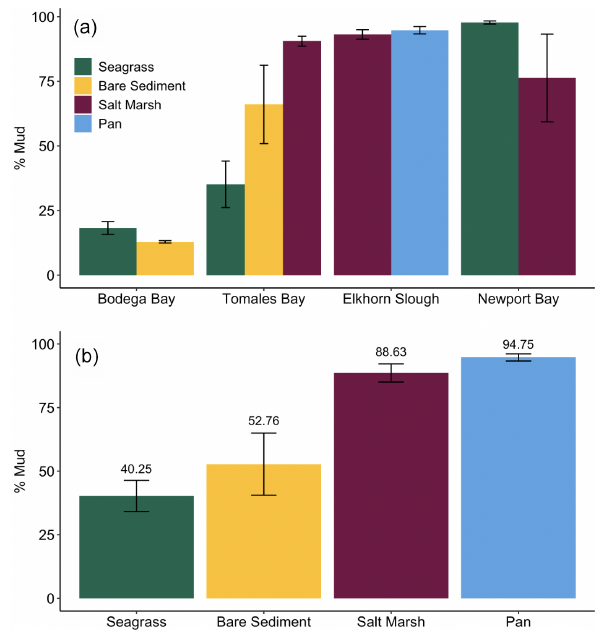
Figure 5. Average ( ± SE) percent mud of all sediments quantified in each site within each habitat type (a) , and average ( ± SE) percent mud in each habitat type across all sites measured (b) .